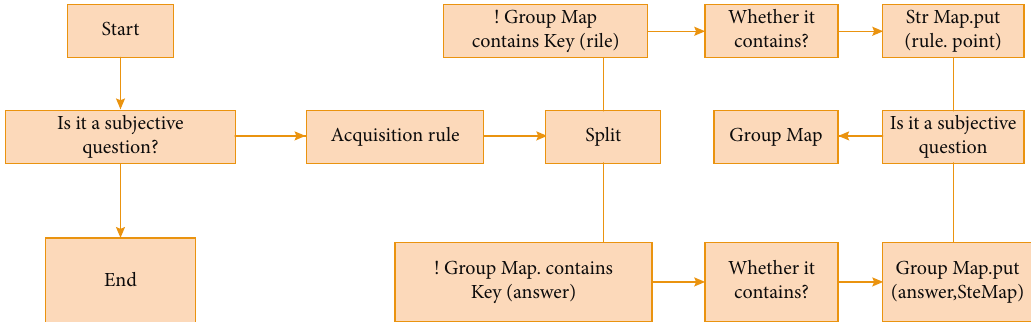
Figure 5: English composition rule initialization